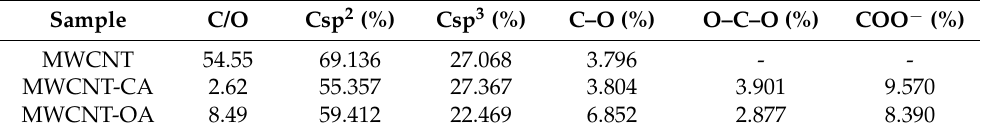
Table 2. X-ray photoelectron spectroscopy (XPS) C1s deconvolution results of MWCNT, MWCNT-CA and